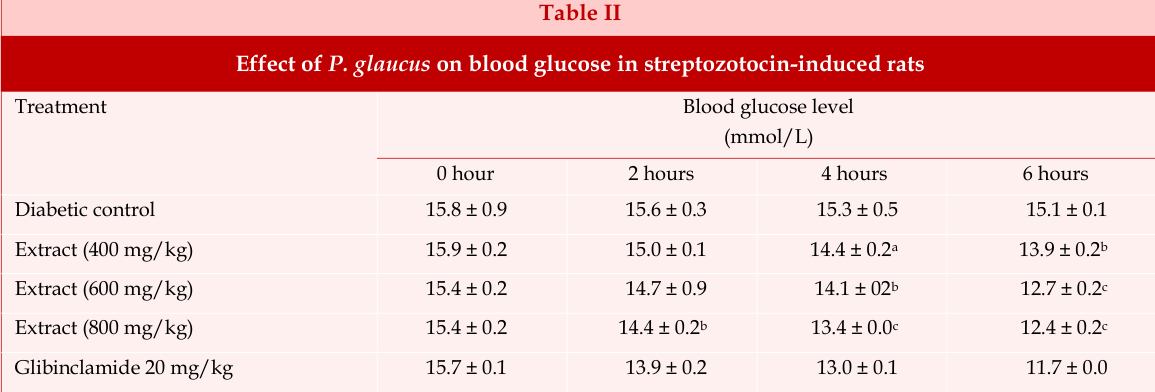
Effect of P. glaucus on blood glucose in streptozotocin-induced